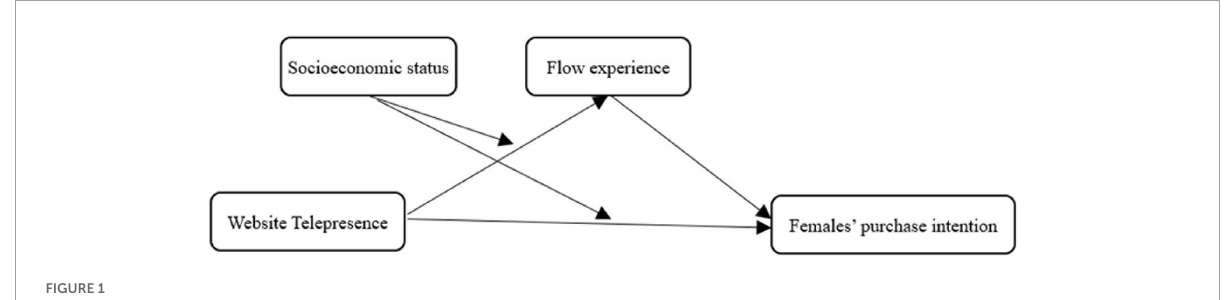
FIGURE1 Conceptual model of this